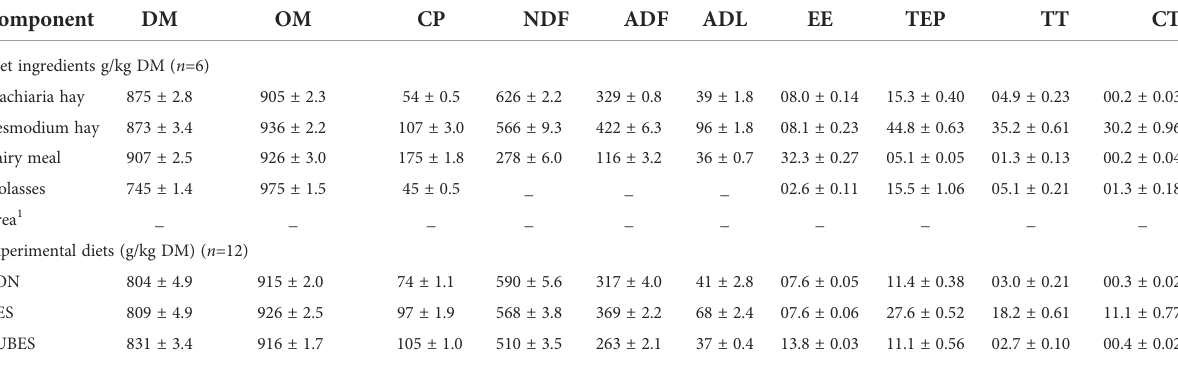
TABLE 3 Chemical composition (g/kg DM, mean ± SE) of the feed ingredients and the formulated experimental diets consisting mainly of Urochloa brizantha var. Xaraes hay as the basal diet (CON) and supplemented either with Desmodium intortum hay (DES) or commercial dairy supplement